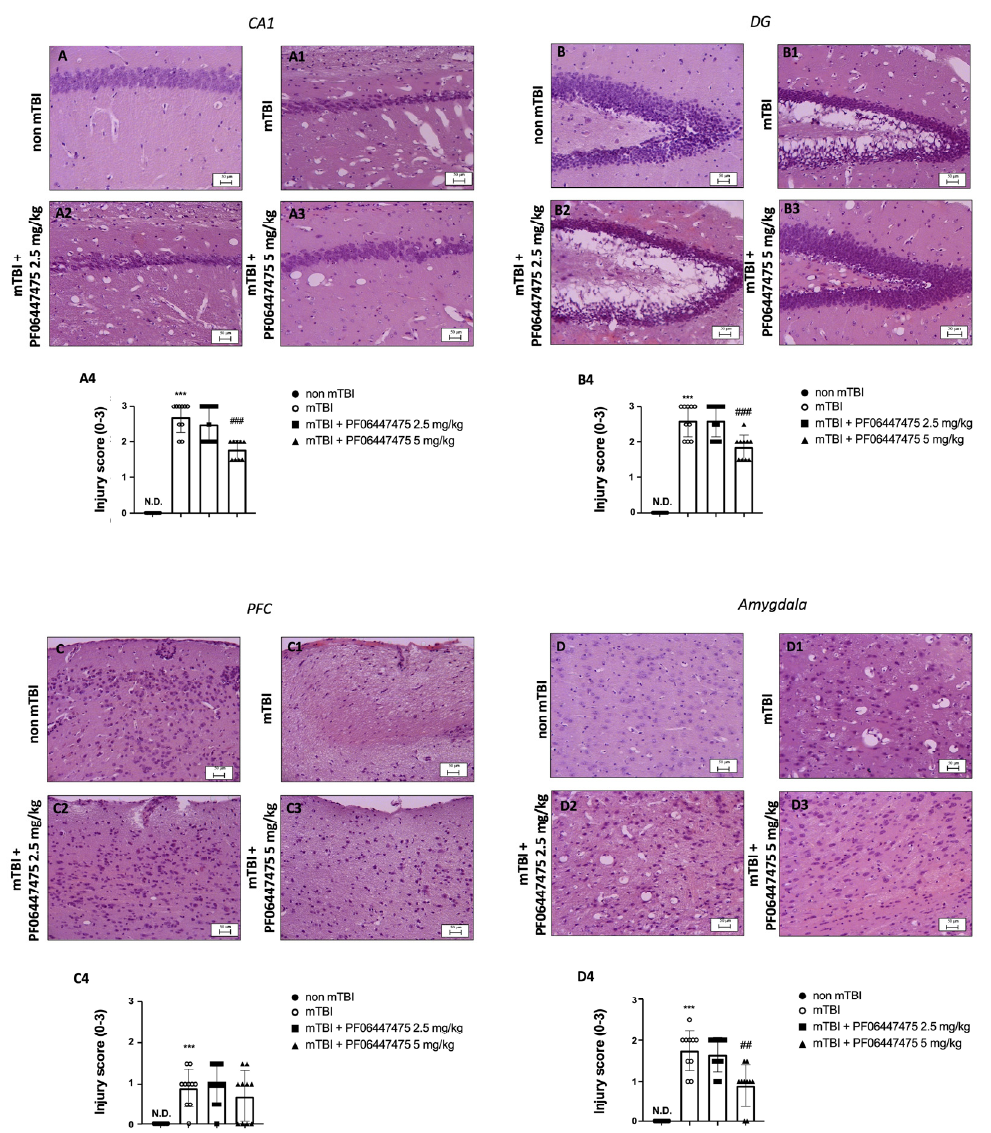
Figure 1. Effects of PF-475 treatments on histological features after mTBI in the CA1, DG, PFC and amygdala areas. CA1 area: H&E staining of the non-mTBI group ( A ) and the mTBI group ( A1 ), see injury score ( A4 ). PF-475 treatments (2.5 mg/kg ( A2 ) and 5 mg/kg ( A3 )), see injury score ( A4 ). DG area: H&E staining of the non-mTBI group ( B ) and the mTBI group ( B1 ), see injury score ( B4 ). PF-475 treatments (2.5 mg/kg ( B2 ) and 5 mg/kg ( B3 )), see injury score ( B4 ). PFC area: H&E staining of the non-mTBI group ( C ) and the mTBI group ( C1 ), see injury score ( C4 ). PF-475 treatments (2.5 mg/kg ( C2 ) and 5 mg/kg ( C3 )), see injury score ( C4 ). Amygdala area: H&E staining of the non-mTBI group ( D ) and the mTBI group ( D1 ), see injury score ( D4 ). PF-475 treatments (2.5 mg/kg ( D2 ) and 5 mg/kg ( D3 )), see injury score ( D4 ). Data are expressed as SD from 10 mice for each group. Two-way ANOVA test. (ND) Not detectable. *** p < 0.001 vs. non-mTBI; ## p < 0.01 and ### p < 0.001 vs. mTBI.